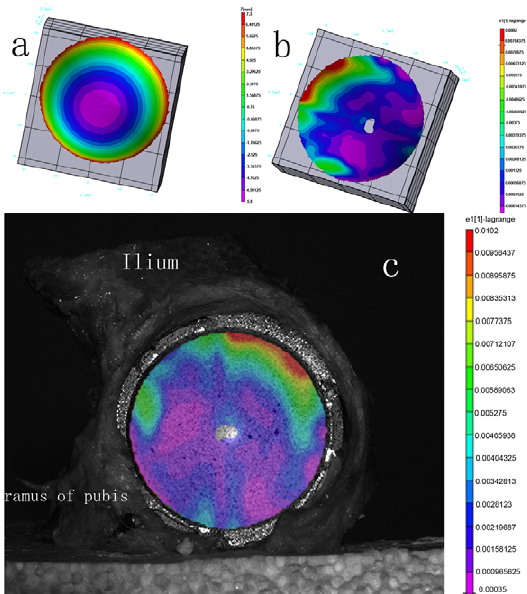
Figure 4. (a)The image of Durom cup before implantation (b)The image of Durom cup after implantation. (c) the image of the cup in the pelvis and location of deformation.